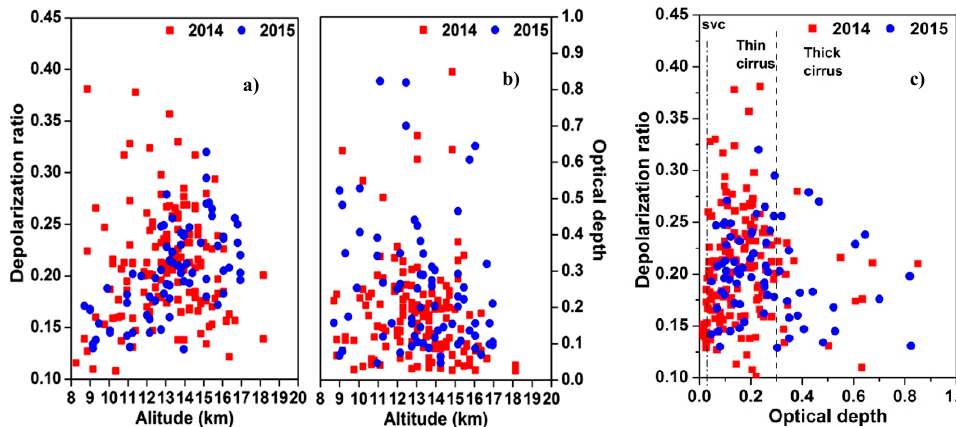
Figure 10. ( a , b ) represents the height variation of the depolarization ratio and the optical depth and ( c ) represents the dependence of the measured optical depth categorized with the depolarization ratio during the period of observation.